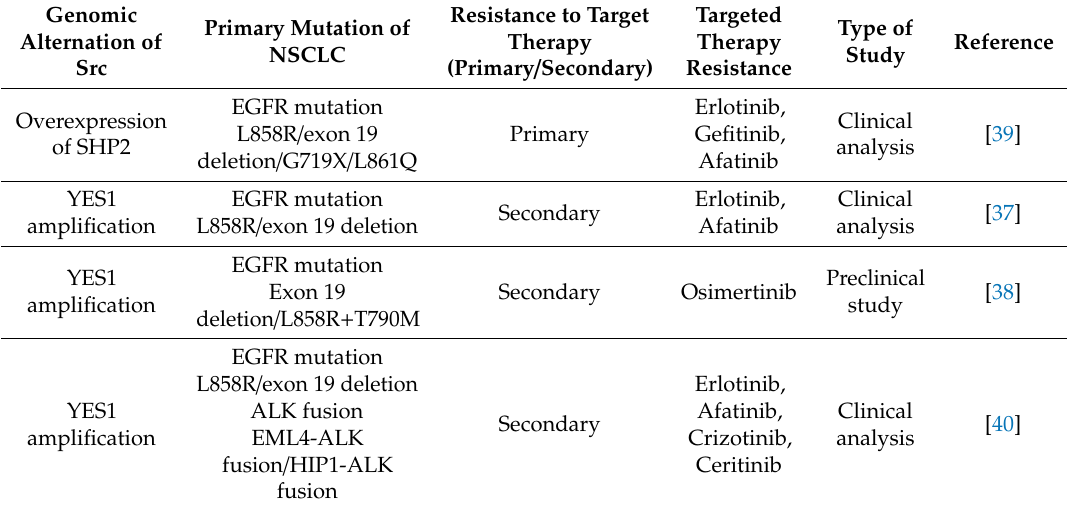
Table 1. Src-altered resistance to targeted therapy in non-small-cell lung cancer